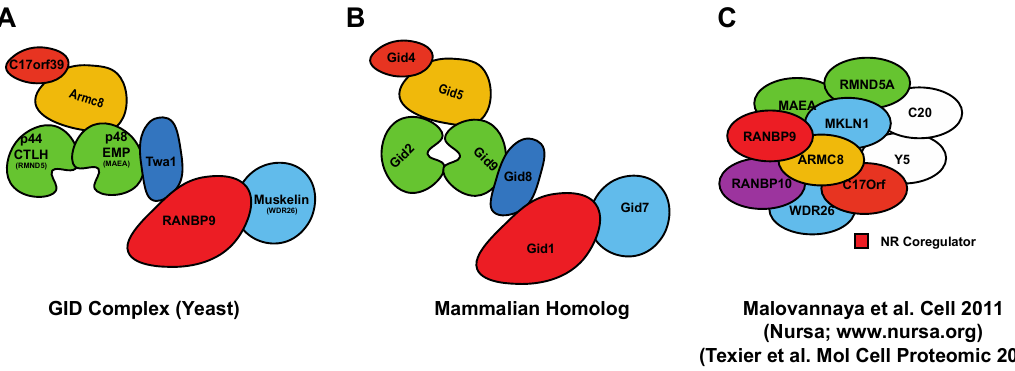
Figure 2. Schematic representation of the S. cerevisiae Glucose-Induced degradation Deficient (GID)- and correspondent mammalian CTLH-macromolecular complexes. ( A ) The topology of the GID complex in yeast is well established [31]; ( B ) Predicted composition of the mammalian CTLH complex based on the GID mammalian homologs. The name of the complex comes from the CTLH domain that most of the members have; ( C ) CTLH or Nuclear Receptor coregulator-complex pulled down from mammalian cells including RANBP9 and RANBP10 (adapted from [29]). In the depicted complex, GID8 is named C20orf11 and indicated as C20. The experiment showed as part of the complex also YPEL5 (Yippee Like 5) indicated as Y5 in the cartoon, which has no known equivalent in the S. cerevisiae GID complex.